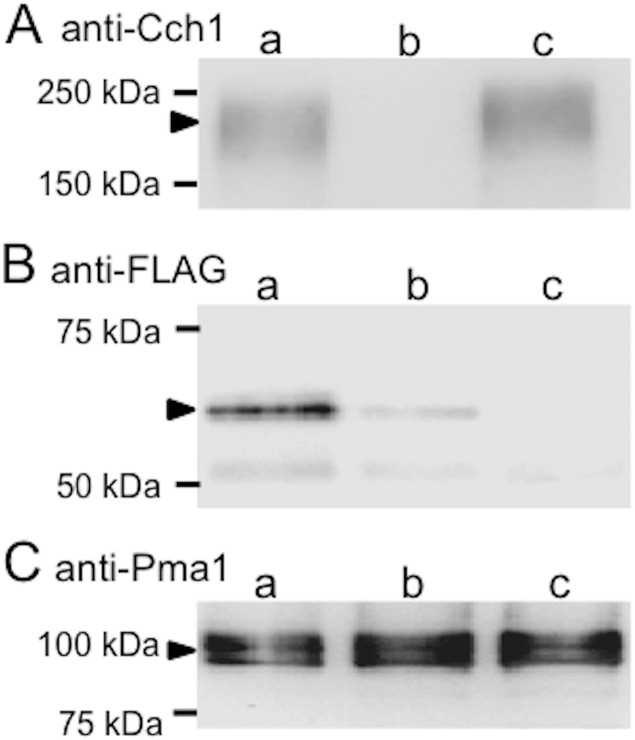
Co-immunoprecipitation and co-localization.(A, B) The membrane fraction was immunoprecipitated with an anti-Cch1 antibody and co-immunoprecipitated proteins were subjected to Western blotting in order to detect FLAG-tagged Scs2. (C) An aliquot of the membrane fraction used above was directly subjected to Western blotting to detect the plasma membrane marker protein Pma1. The strain used was SK3011 (scs2Δ cch1Δ) carrying either pBCT-CCH1H + YCpT-NubG-FL5-SCS2 (lane a), pBC111 (empty vector) + YCpT-NubG-FL5-SCS2 (lane b), or pBCT-CCH1H + YCpT-NubG-FL5N (empty vector) (lane c). Arrowheads point to the Cch1 (A), FLAG-tagged SCS2 (B) and Pma1 (C) proteins. In lane b, a faint band was observed for an unknown reason.